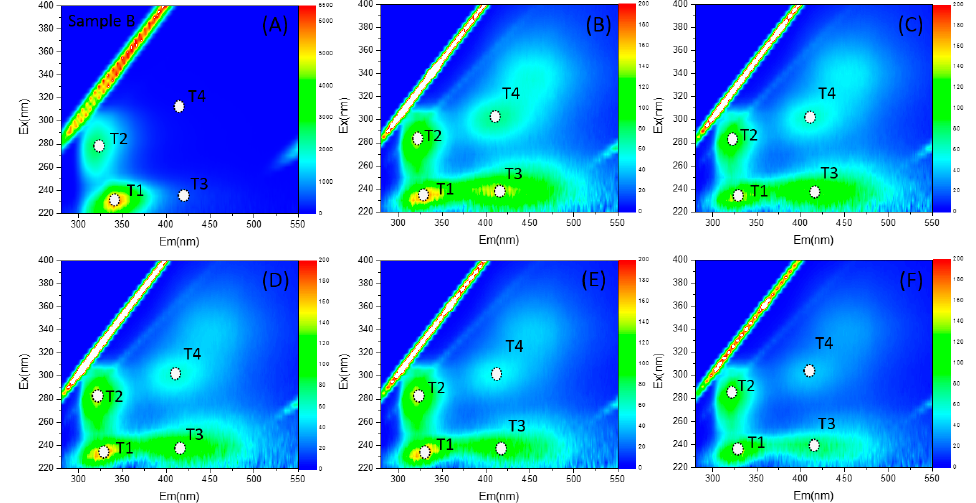
Figure 2. EEM spectra of sample B before ( A ) and after ozonation ( B ), catalytic ozonation by the catalysts ( C – F ) with fluorescence regions and peak maxima indicated for humic-like substances (Ex: 300–370 nm, Em: 400–500 nm), fulvic-like substances (Ex: 237–260 nm, Em: 400–500 nm) and protein-like structures (Ex: 235–240 nm, Em: 340–355 nm; Ex: 280–285 nm, Em: 320–335 nm).